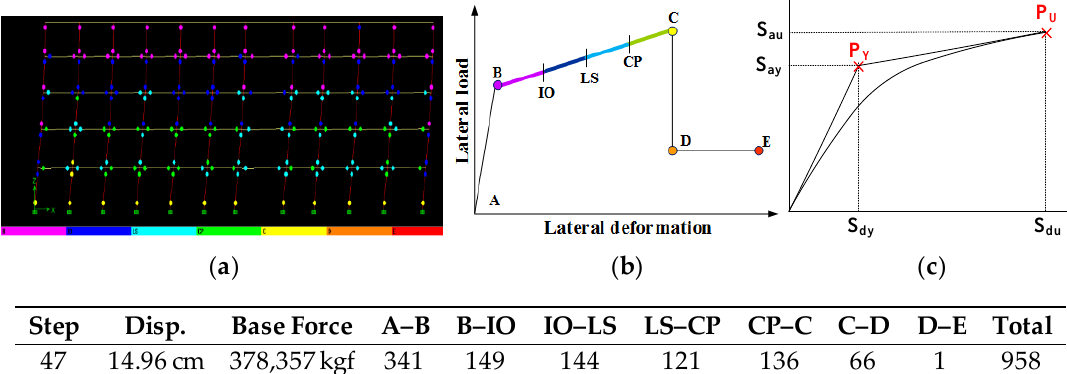
Figure 3. ( a ) Damage states of structural components at the ultimate point 𝑃 𝑈 ; ( b ) Deformation-load relation of a structural component; ( c ) Capacity curve.